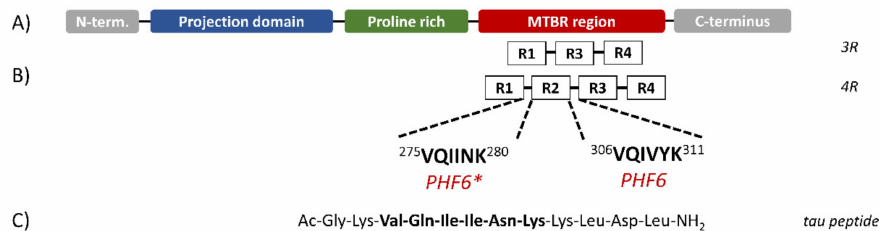
Figure 1. Schematic structure of Tau isoforms. ( A ) Tau protein can be divided in three domains: the N-terminal projection domain containing two alternatively spliced exons; a proline-rich region; the microtubule-binding region (MTBR). ( B ) The MTBR region may contain three ( 3R ) or four ( 4R ) pseudo-repeat units (R1 to R4) separated by short inter-repeat regions where the PHF6 and PHF6* segments are located. ( C ) Sequence of the synthesized peptide. (Figure redrawn from Ref.